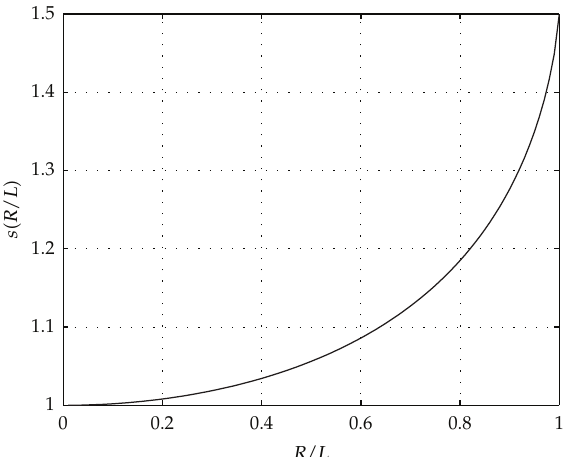
Figure 6: Geometrical factor s (cid:3) R/L (cid:4) for a sphere of radius R whose center is at distance L from the source.